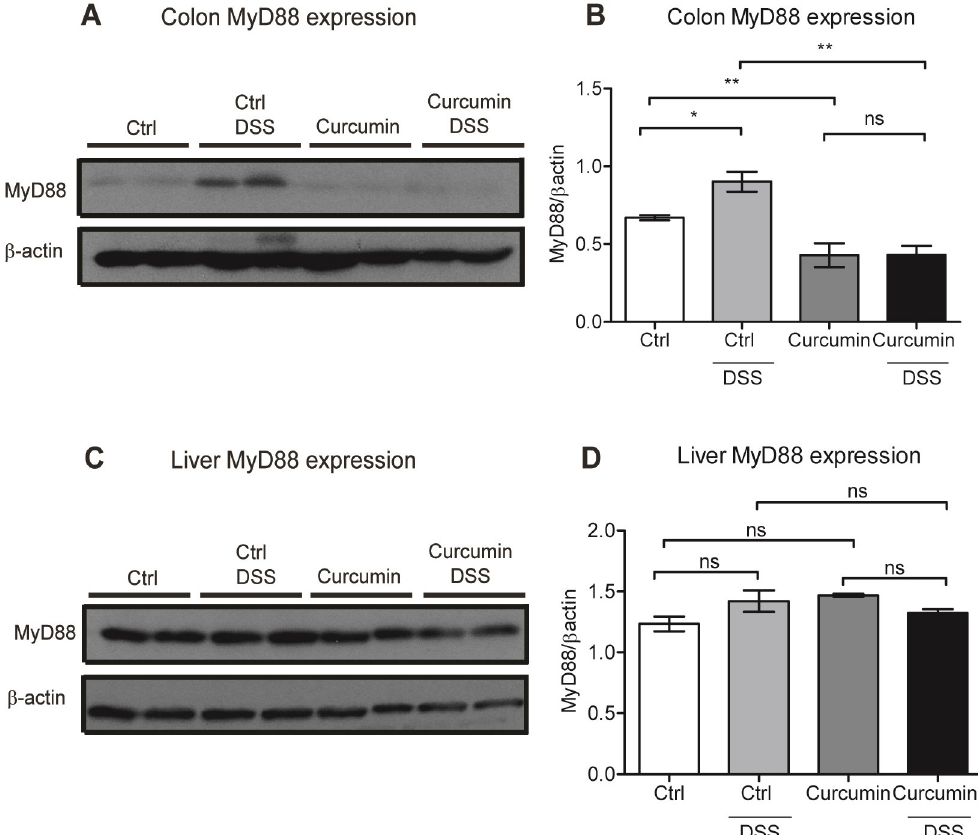
Fig 4. Curcumin decreases MyD88 protein expression in the colon but not in the liver. (A-B) Colonic MyD88 protein expression in C57BL/6 mice treated with or without dextran sodium sulfate (DSS) and fed an iron-sufficient diet (Ctrl) or iron-sufficient diet supplemented with curcumin (Curcumin). (A) Representative western blot of colon protein extracts probed with antibodies against MyD88 and β -actin. Each lane represents an individual mouse. (B) Graphic depicting densitometric quantification of western blots from three independent experiments. (C-D) Hepatic MyD88 protein expression. (C) Representative western blot of liver protein extracts probed with antibodies against MyD88 and β -actin. (D) Graphic depicting densitometric quantification of western blots from three independent experiments. Statistical analysis was performed with one-way ANOVA: data in B and D are presented as mean ± SEM. Statistical analysis was performed by two-tailed Student’s t -test. � P < 0.05, �� P < 0.01; ns = not significant; n = 8 mice per